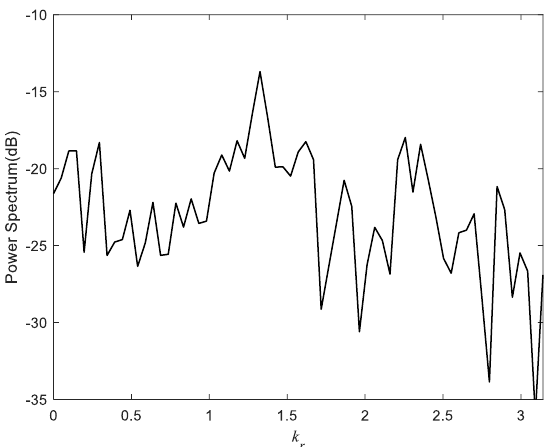
Figure 10. The horizontal wavenumber spectrum of the first-time step. The maximum value is at k r = 1.325.